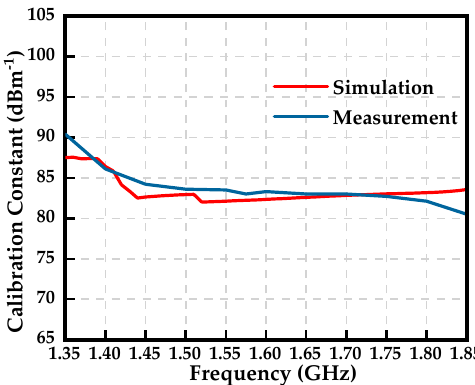
Figure 10. Simulated and measured transmission coefficient of the proposed sensor.